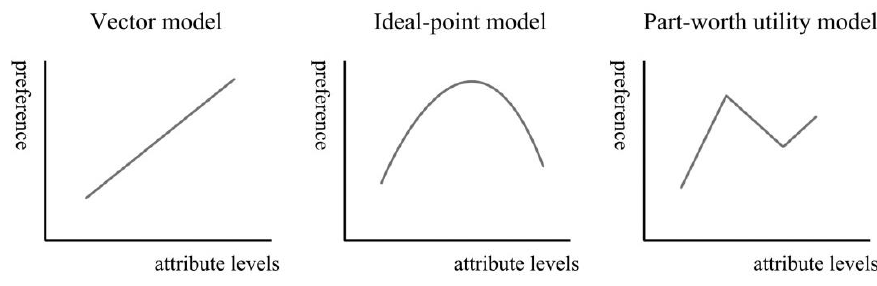
Figure 3. Types of preferences model.